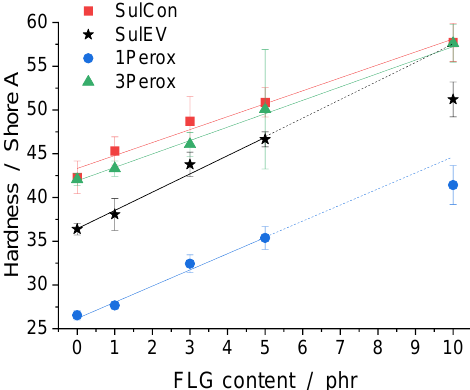
Figure 4. Shore A hardness for all curing systems over FLG content.